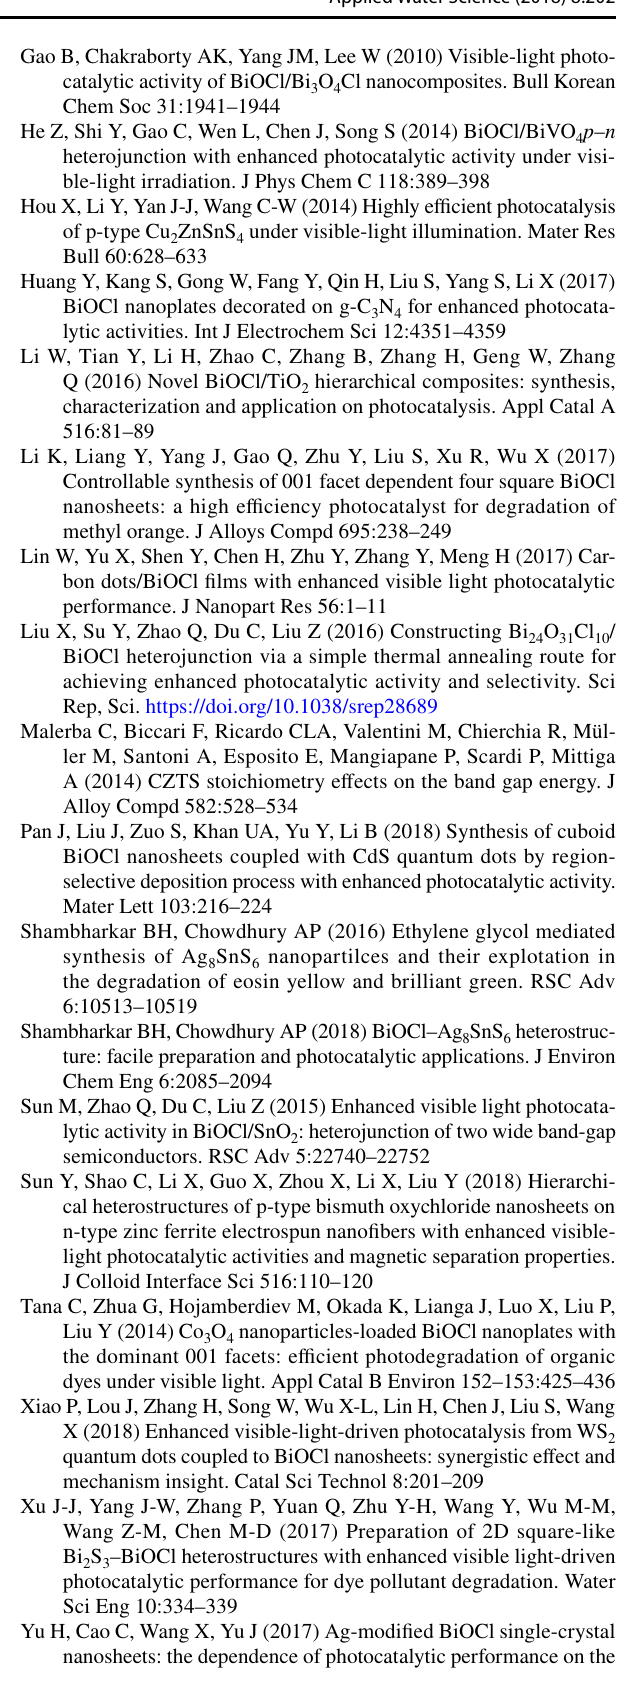
Fig. 10 Scheme of electron transfer in BiOCl–Cu